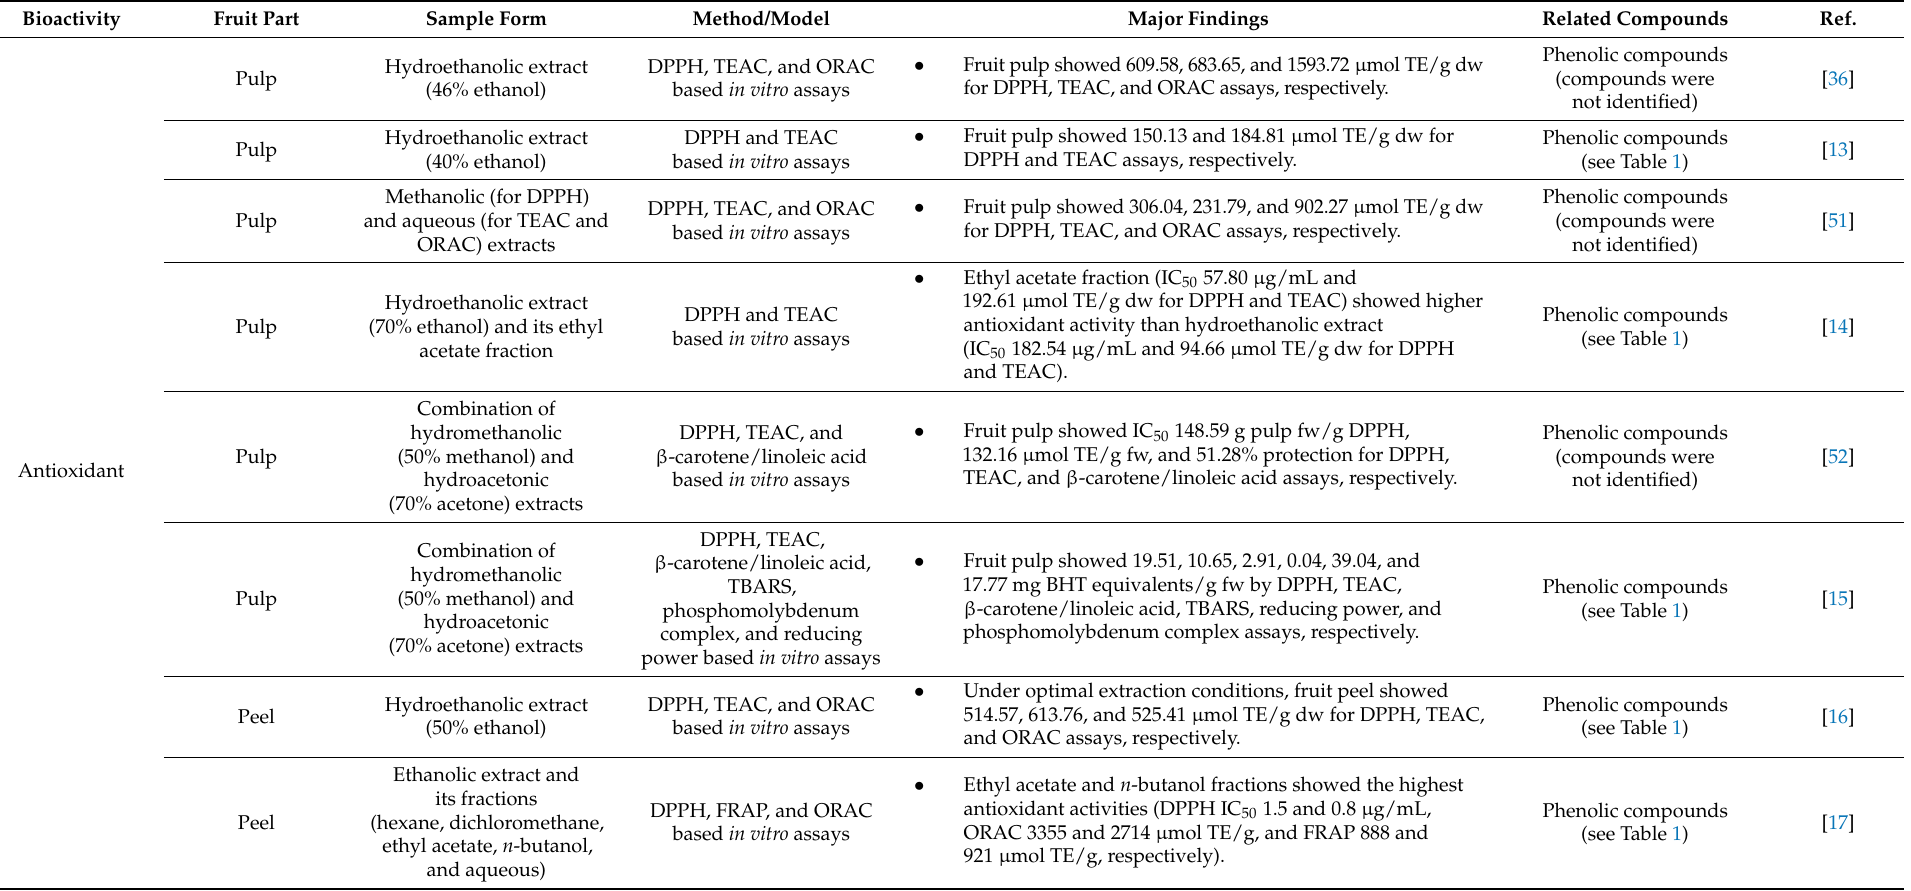
Table 2. A summary of studies showing the biological activities of extracts from edible parts and by-products of araticum